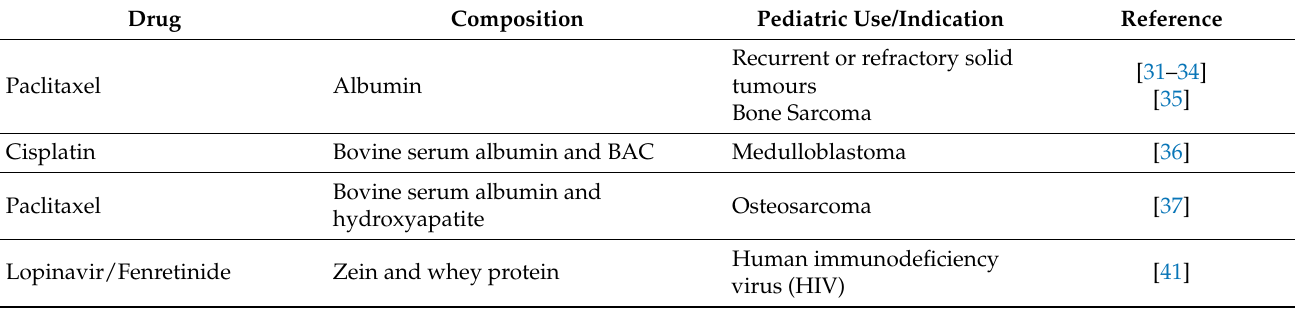
Table 1. Polymeric nanoparticles studied as drug carriers in